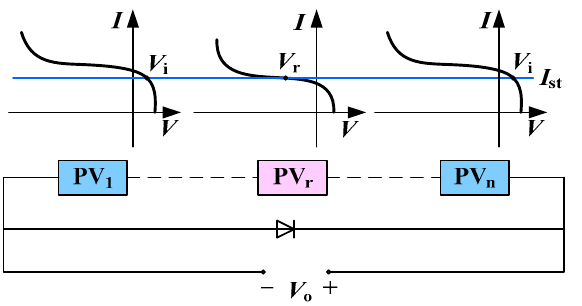
Figure 2. Photovoltaic cell single-diode model: ( a ) normal photovoltaic cell; ( b ) hot spot cell.